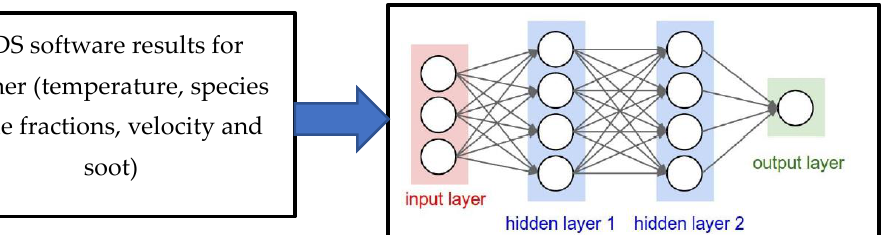
Figure 3. Schematics of the computational process algorithm of the pet-coke burner.